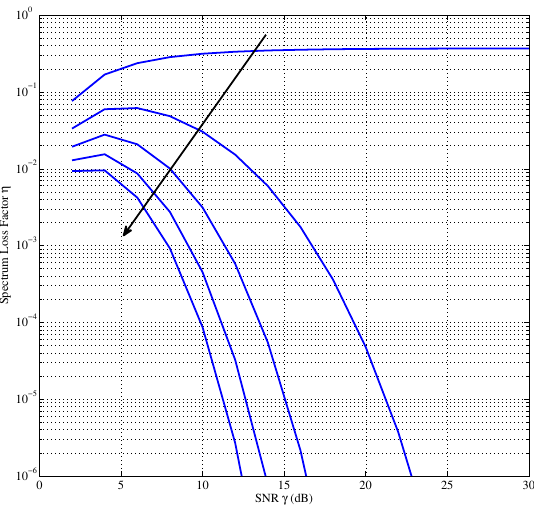
Figure 6. The reliability-oriented scheme for HCoS with η ≤ 0 . 01 . k = N 0 . Along the direction of the arrow, N = 1 , 2 , 3 , 4 , 5 .